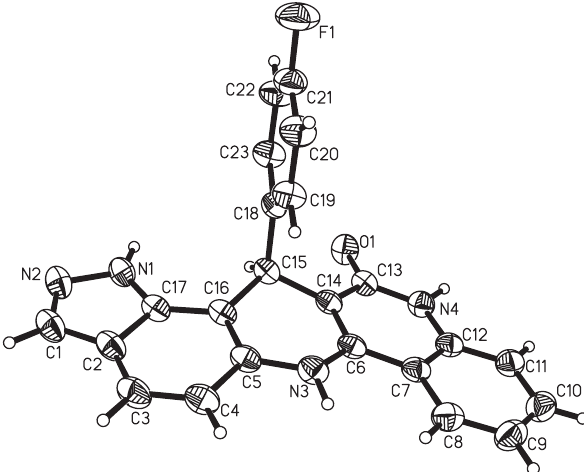
Figure 1: The molecule structure of the title compound (solvate DMF and H 2 O omission) showing 30% probability displacement ellipsoids and the atom-numbering scheme.